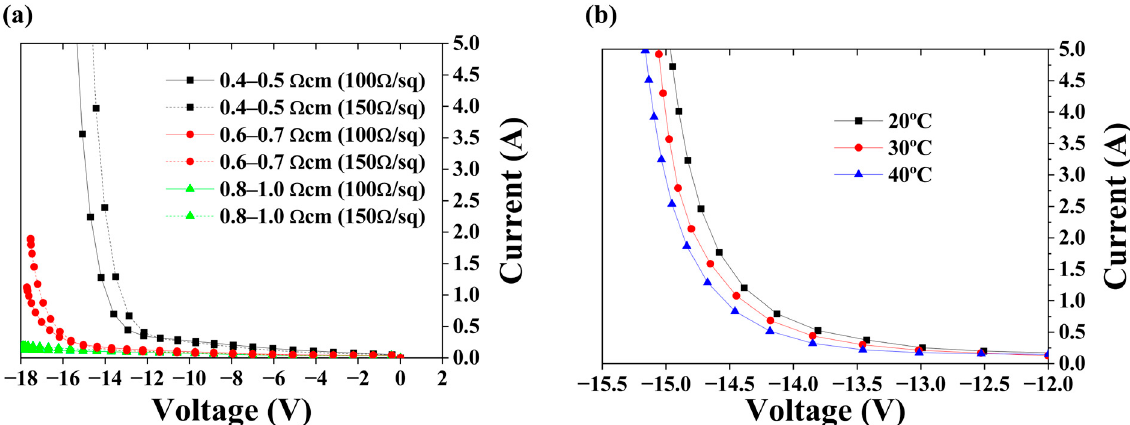
Figure 1. ( a ) Dark reverse I – V curves of gallium-doped PERC cells with different resistivities and diffusion sheet resistances. ( b ) Dark reverse I–V curves of gallium-doped PERC cells with a resistivity of 0.4 – 0.5 Ω cm and a sheet resistance of 150 Ω /sq at different test temperature.